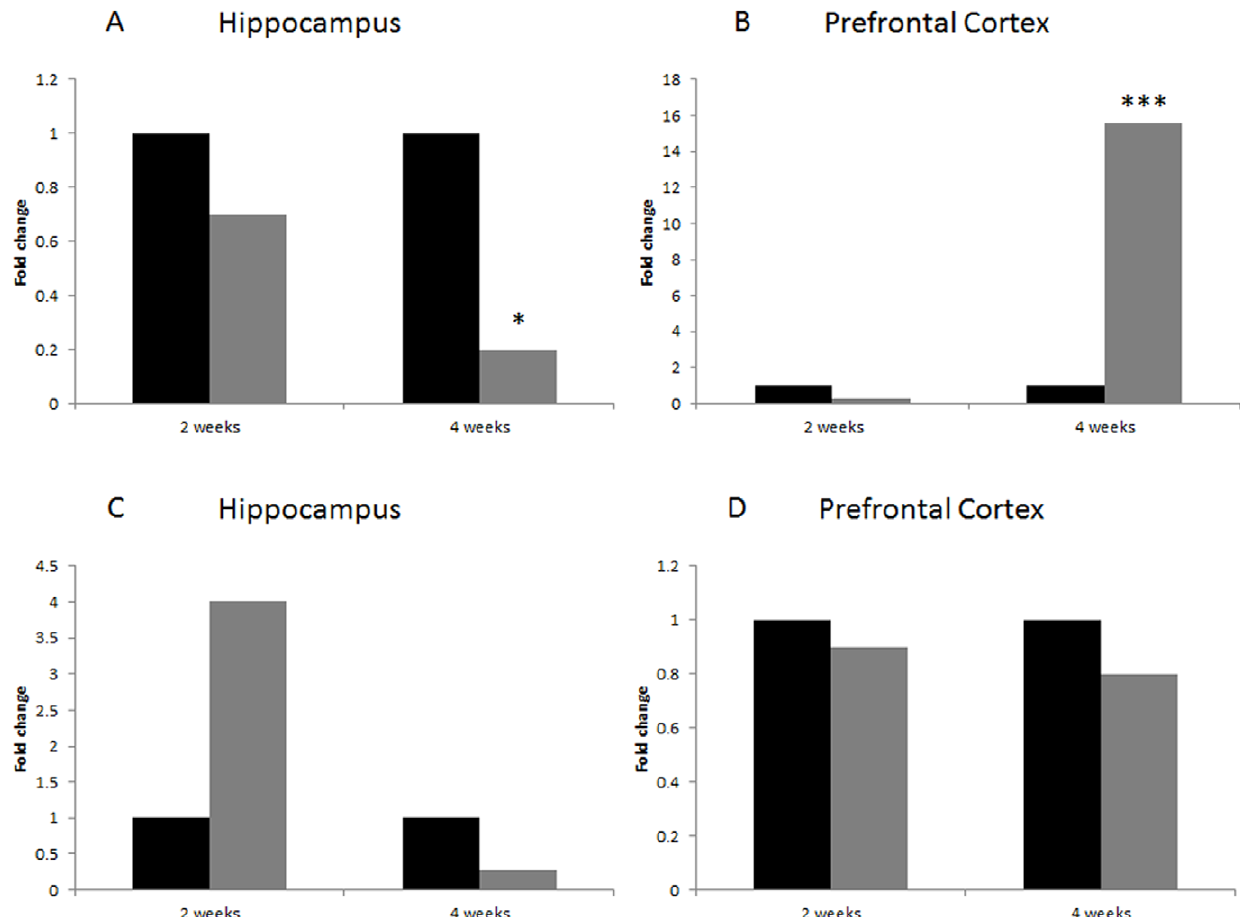
Figure 6. qRT-PCR analysis of Prlr (A, B) and Adipoq (C, D) expression level. Data are represented as a normalized relative fold change to control. Asterisks represent statistical significance (* p , 0.01; *** p , 0.001). Control animals are represented in black, stressed animals in grey. For more details see (Tables S3, S4, S5, S6). It should be noted that the level of Adipoq expression in hippocampus is very low (C(t) values . 40 and beyond detection), which results in a high fold change that is not